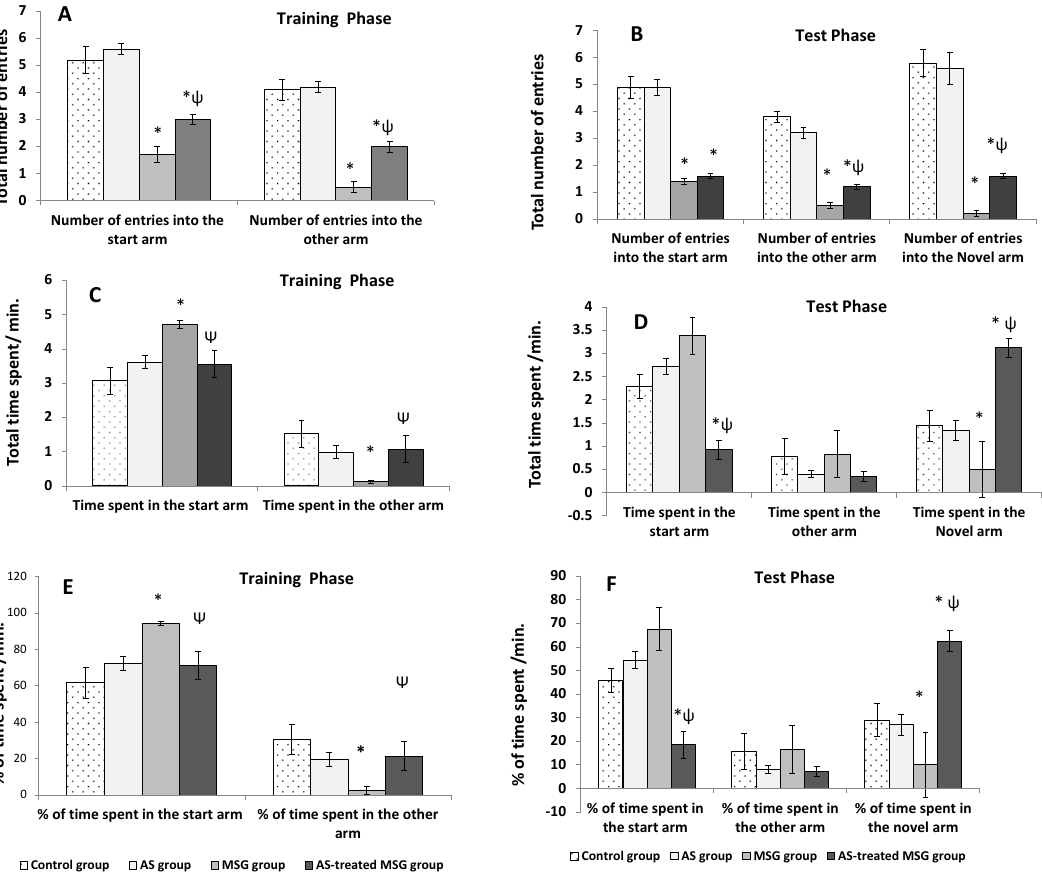
Figure 4. Short-term spatial memory tested by modified T-maze in di ff erent studied groups: ( A ) the number of entries in the training phase; ( B ) the number of entries in the test phase; ( C ) the time spent in the training phase; ( D ) the time spent in the test phase; ( E ) the percentage of time spent in the training phase; ( F ) the percentage of time spent in the test phase. Data are expressed as mean ± S.E.M. ( n = 10). * p < 0.05, vs. control; ψ p < 0.05, vs.